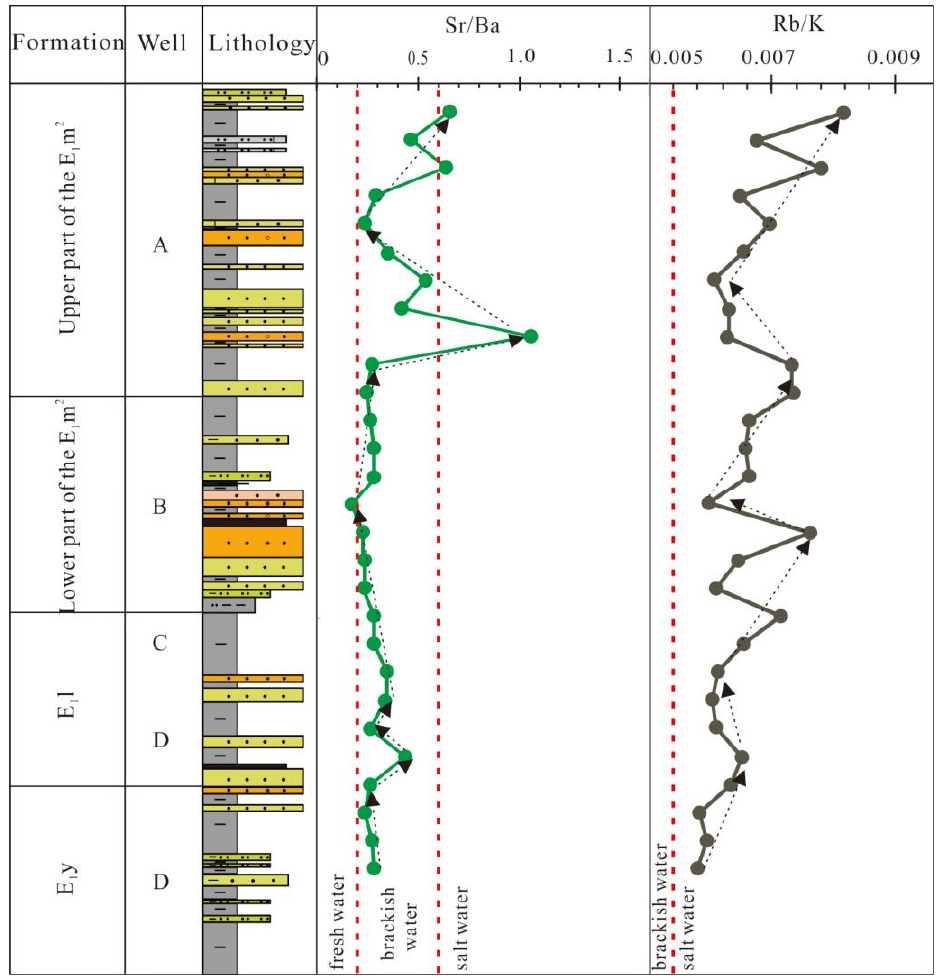
Figure 16. The paleosalinity evolution profile of the Paleocene in the West Lishui Sag.